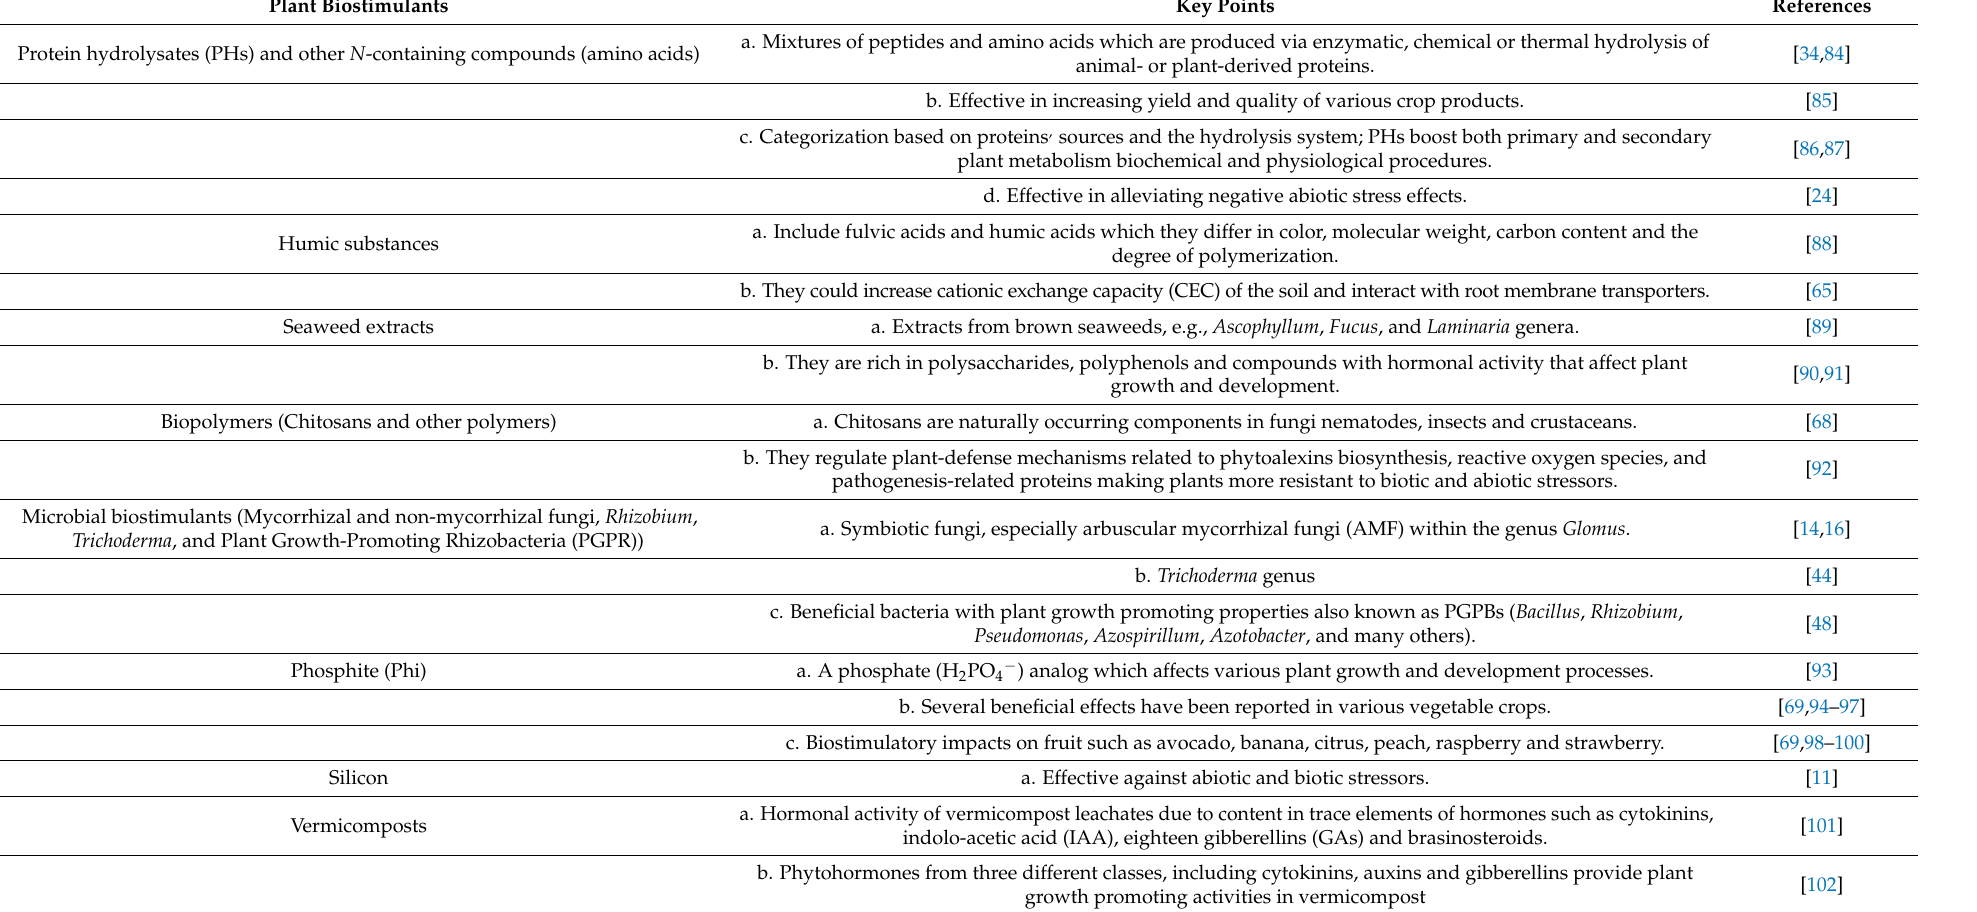
Table 1. Classification of plant